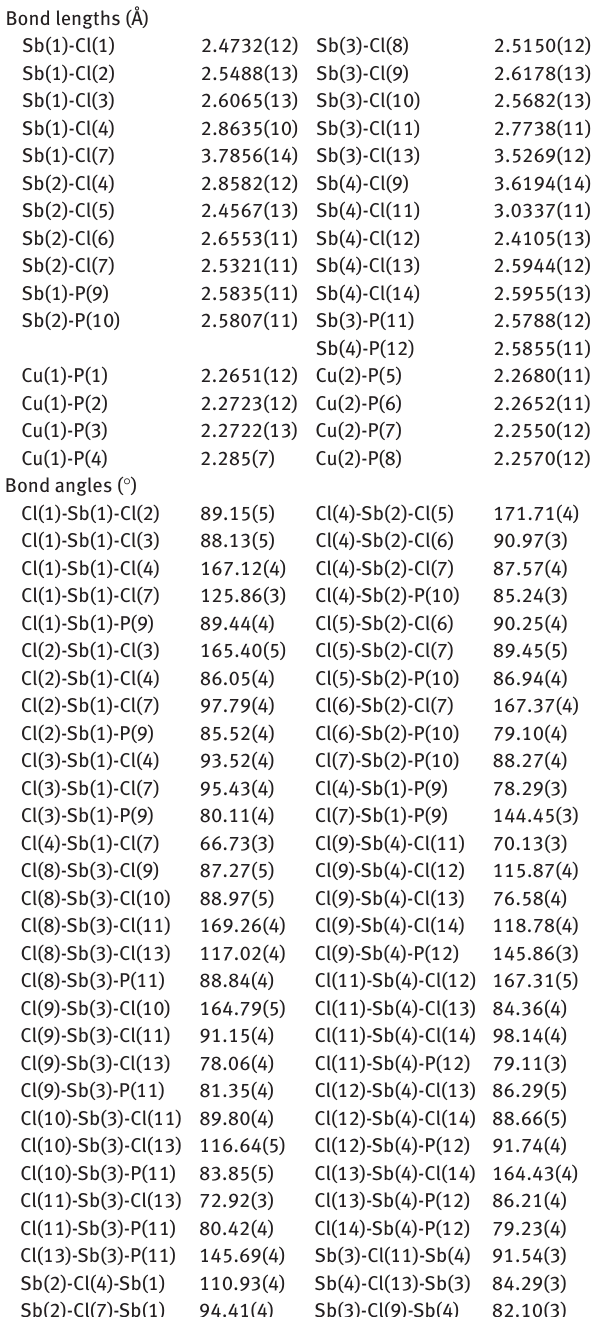
Table 2 Selected geometric data (Å, ° ) for 9